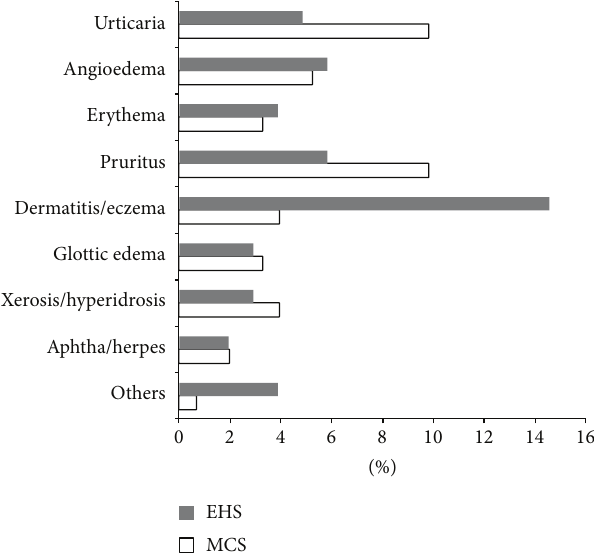
Figure 4: Skin manifestations (common symptoms and specific diseases) registered in the case histories of the groups of patients self-reporting electromagnetic hypersensitivity (EHS, 𝑛 = 153 ) and of patients affected by multiple chemical sensitivity without EHS symptoms (MCS, 𝑛 = 147 ). Data are expressed as percentage of patients affected by each specific class of cutaneous